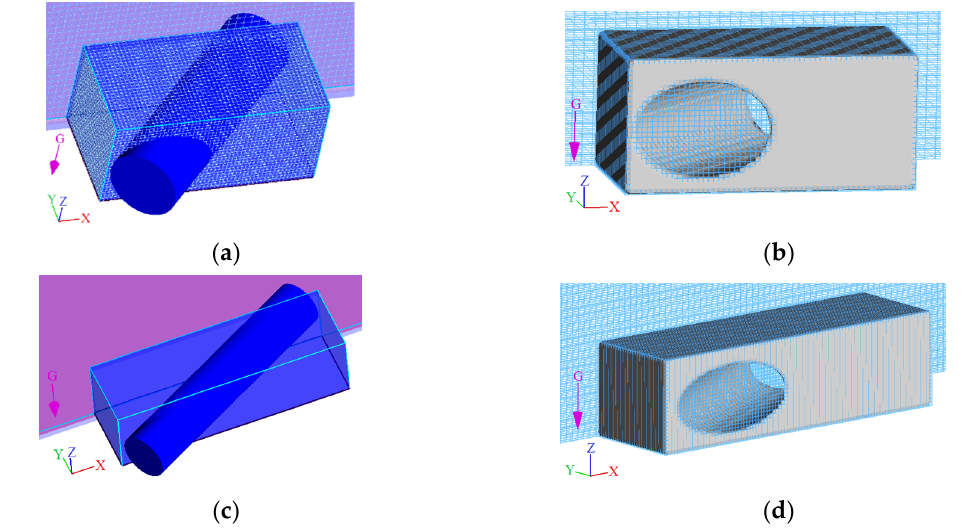
Figure 19. ( a ) and ( c ): Pipe defined as a hole that passes through the channel wall and the pipe Figure 19. ( a , c ): Pipe defined as a hole that passes through the channel wall and the pipe complement; complement; ( b ) and ( d ): Favored view of the lateral inlet pipe. ( b , d ): Favored view of the lateral inlet pipe.